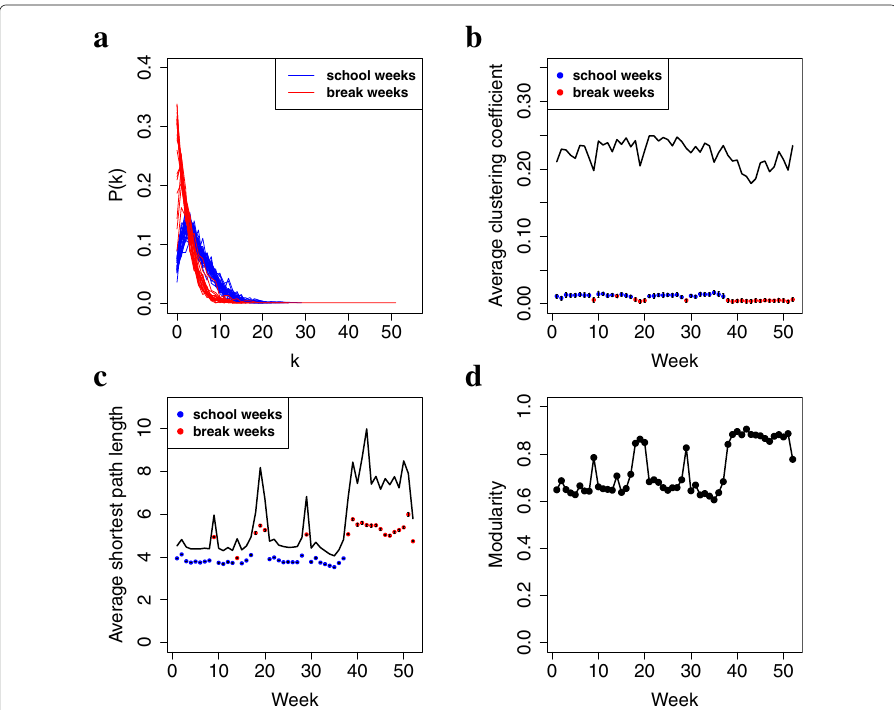
Fig. 3 Global properties of the school or break week network snapshots: a degree distributions; b average clustering coefficients (solid line); c average shortest path lengths (solid line); and d modularity. In panels b and c , dots represent average clustering coefficients and average shortest path lengths, respectively, that would be expected by chance in networks of the same size, according to the degree distribution-preserving random graph model (ERDD)